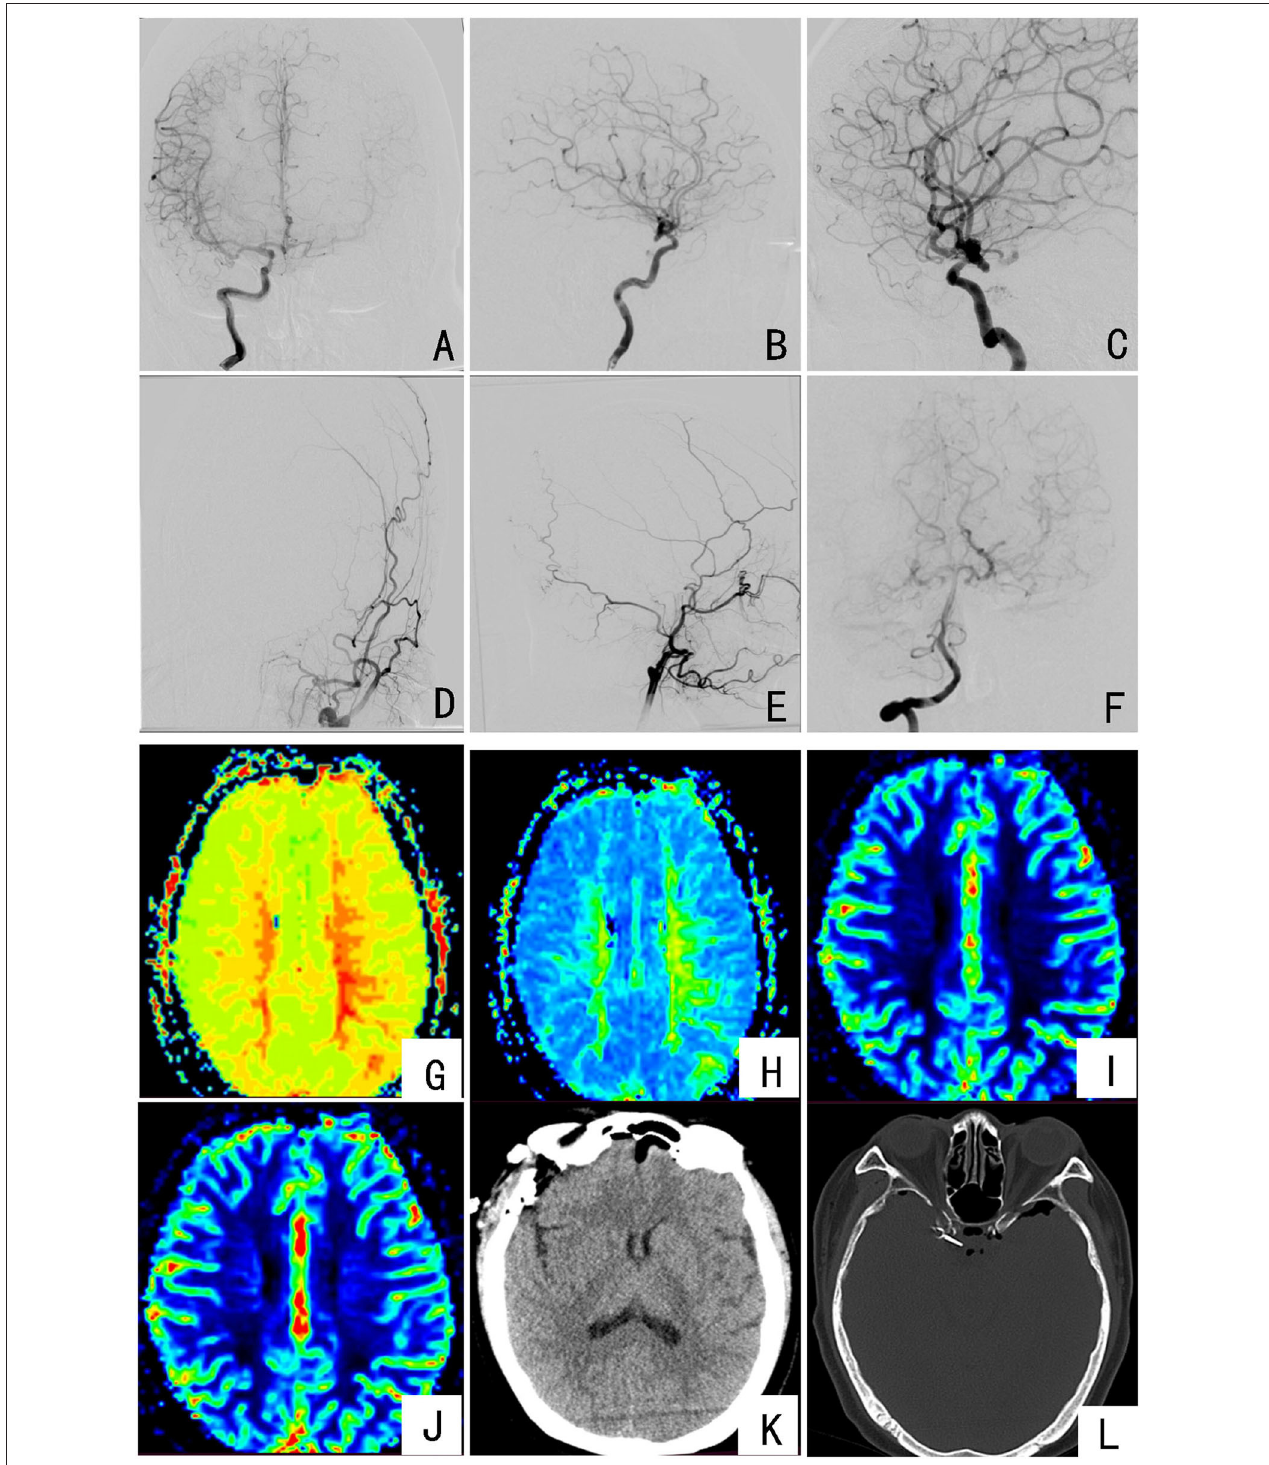
FIGURE 1 | Preoperative and postoperative imaging examinations of the patient: (A–C) DSA imaging showing the right internal carotid artery communication segment considering an aneurysm; (D,E) DSA imaging showing intracranial occlusion of the left internal carotid artery; (F) DSA imaging showing the posterior circulation is clearly compensated to the left brain; (G,H) PWI indicates the left frontotemporal lobe TTP and MTT extension; (I,J) PWI indicates the CBV of the left frontal lobe increased and the CBV of the left temporal lobe decreased, but the bilateral CBF did not change significantly; (K,L) the results of the patient’s head CT on the first day after surgery, with aneurysm